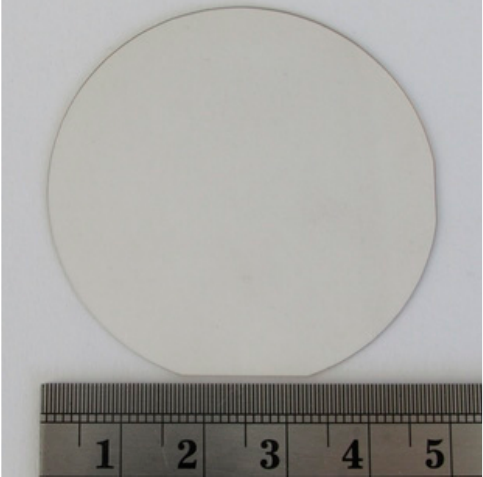
Figure 2. A photograph of bulk GaN crystals grown in the previous higher-oxygen condition ( left ) and the latest lower-oxygen condition ( right ). Coloration was significantly reduced.